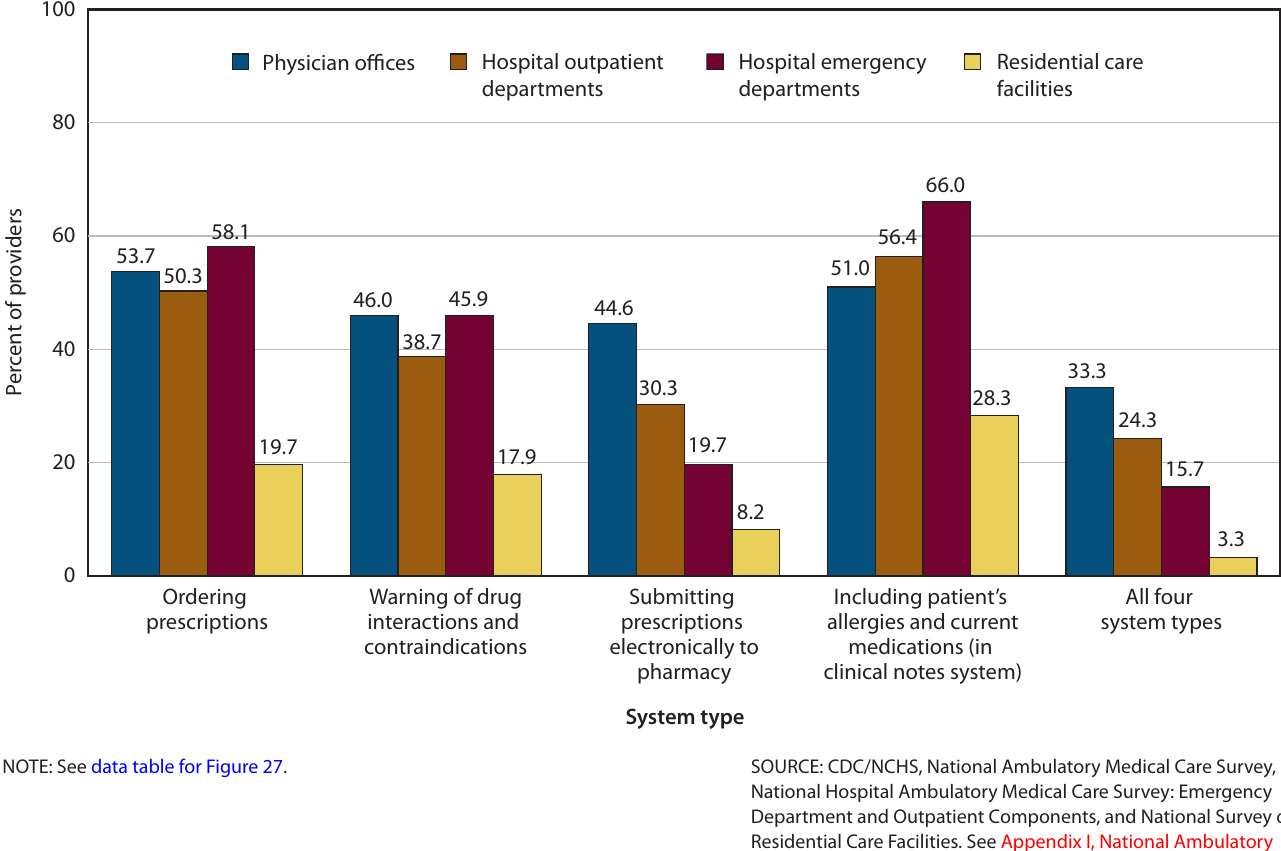
Figure 27. Computerized systems for prescription drugs, by provider and system type: United States,